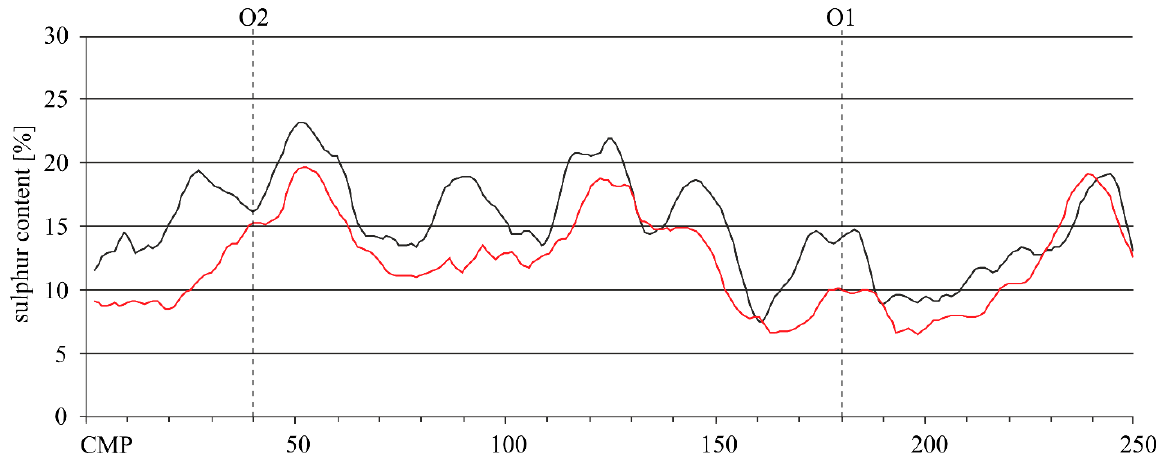
Figure 13. Comparison of sulphur content calculated using both methods along the analyzed seismic cross section. Red line—sulphur calculated from seismic inversion, black line—sulphur calculated from amplitude from the top of the deposit. Both graphs were smoothed with a running average of 3 CMP.